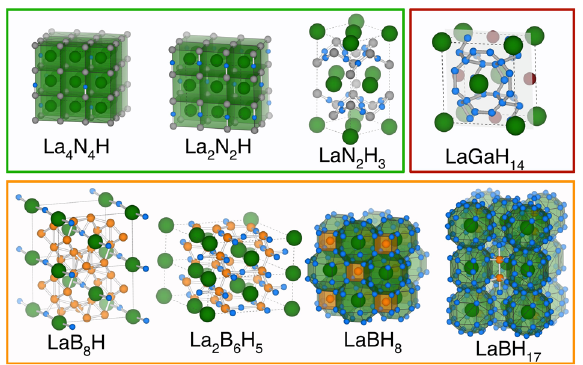
Fig. 2 Crystal structures of the thermodynamically stable La – B – H and La – N – H phases, and metastable LaBH 17 and LaGaH 14 phases. La, B, N, Ga and H atoms are shown as green, orange, gray, red, and blue spheres, respectively. Polyhedral surfaces match the color of the bonding atom. In LaGaH 14 the 001 lattice plane is shown to highlight the planar nature of the hydrogen